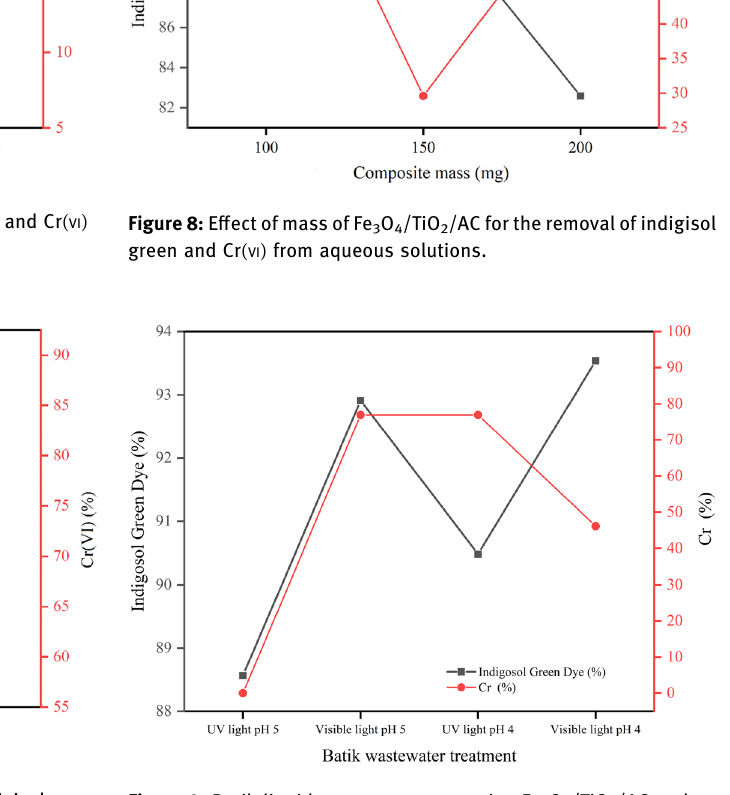
Figure 9: Batik liquid waste treatment using Fe 3 O 4 /TiO 2 /AC under UV - Vis light